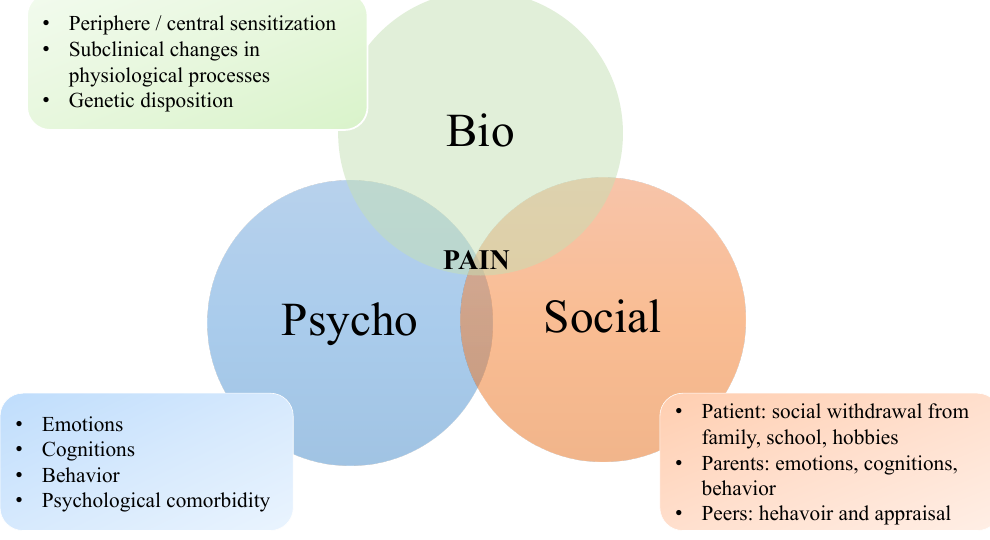
Figure 1. Biopsychosocial model of pain. Based on Wager & Zernikow, 2014